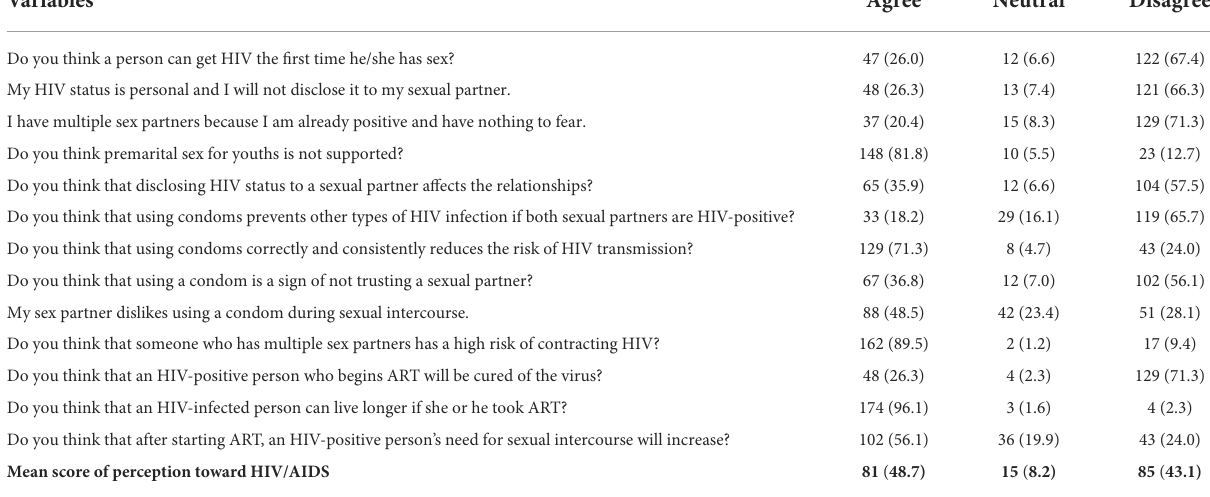
TABLE 3 The respondents’ perception of HIV/AIDS in Andabet district, Ethiopia, 2022. Variables